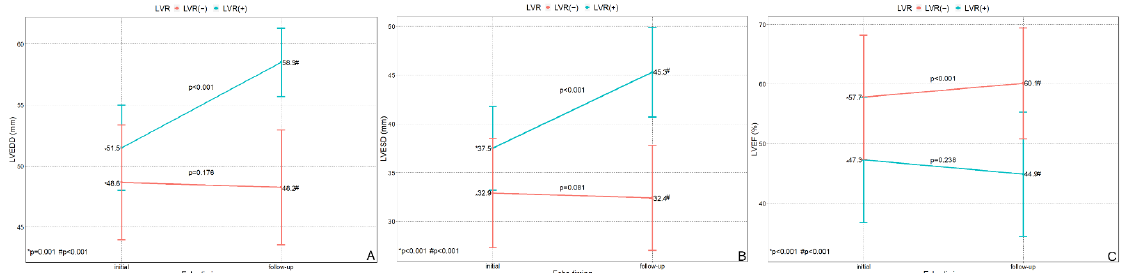
Figure 2. Echocardiographic data at both initial and follow-up echocardiography (performed in 6.66 months as median after index PCI) according to left ventricular remodeling. ( A ) LVEDD, ( B ) LVESD, and ( C ) LVEFLVEDD. LVEDD = left ventricular end-diastolic diameter; LVEF = left ventricular ejec- tion fraction; LVESD = left ventricular end-systolic diameter; LVR = left ventricular remodeling